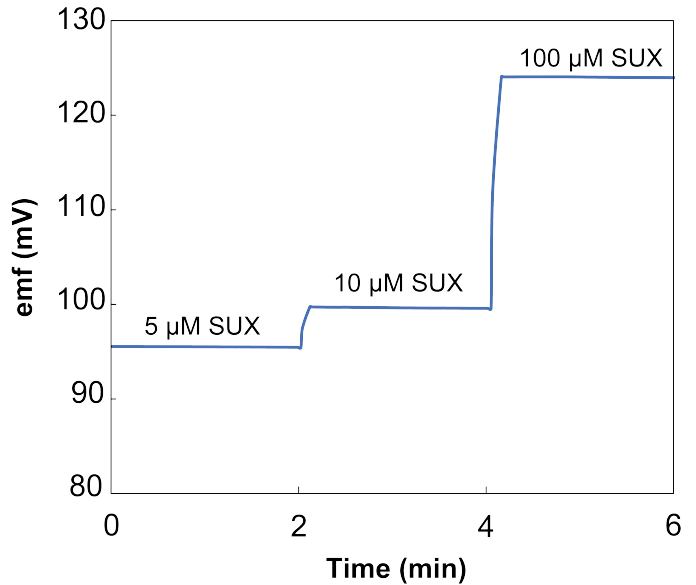
Figure 5. The emf traces from recovery experiments where thread-based ISEs were exposed to 5, 10, and 100 µ M concentrations of SUX in 20%